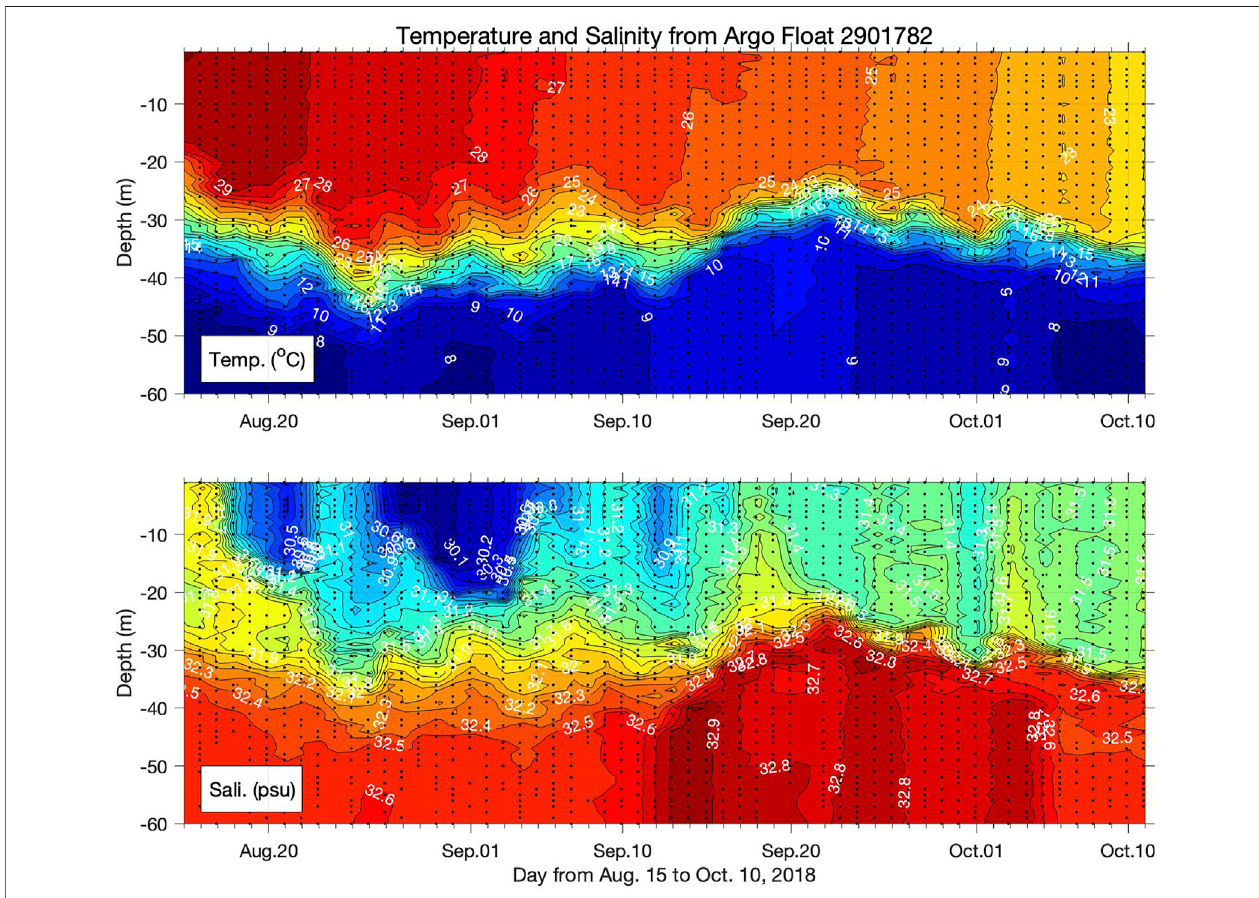
FIGURE4| VerticaldistributionofwatertemperatureandsalinityintheYellowSeaobtainedbyArgo fl oat2901782fromAugust15toOctober10,2018.Theblack dots indicate the observation depths.